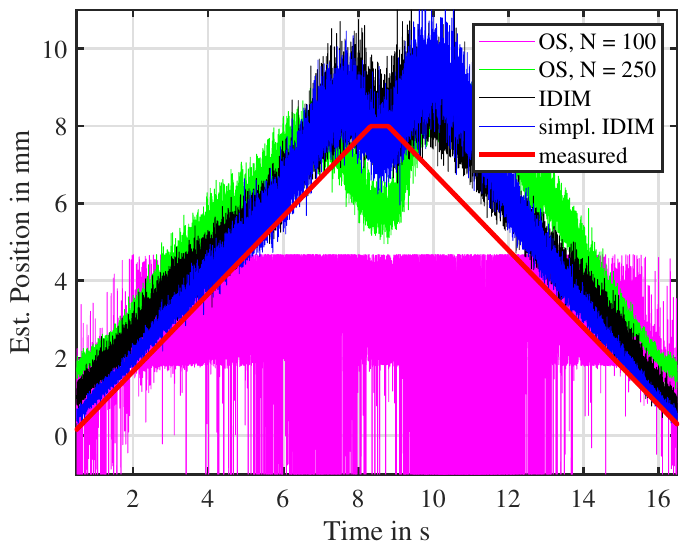
Figure 18. Performance of the obtained sensorless end-position estimator: results are obtained by the IDIM (black), the simplified IDIM approach (blue) and the oversampling approaches with 100 samples (magenta) and 250 samples (green) compared to the position obtained by the high resolution positioning table (red). Results are shown when the actuator is driven with full mean current ( i = 350